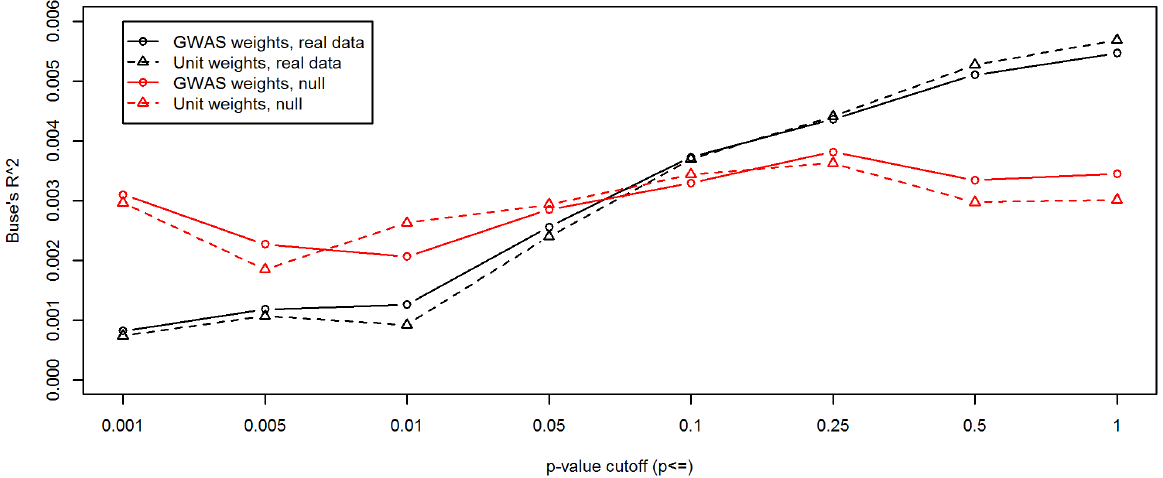
Figure 5. Five-fold cross-validation R 2 of polygenic score (averaged across subsamples, in black) for predicting FSIQ residualized for covariates, compared to results from simulated null data (98 th percentiles, in red). Black lines represent cross-validation Buse’s R 2 [51] for predicting residualized FSIQ, averaged across the 5 subsamples. In each subsample, residualized FSIQ was predicted from polygenic score calculated from regression weights obtained in the other 4 subsamples. ‘‘ P -value cutoff’’ dictated how small a SNP’s p -value had to be in the calibration GWAS to be included in calculating polygenic score for the validation sample. Red lines represent the results of 50 iterations of parametric bootstrapping, which conducted polygenic scoring under cross-validation using data simulated under the null of independence between phenotype and SNP genotypes (conditional on covariates). Each point plotted for the red lines is the 98 th percentile, among the 50 iterations of parametric bootstrapping, of R 2 at that p -value cutoff. Polygenic score was either calculated directly from the GWAS weights (solid lines) or from signed unit weights (dashed lines; see text).